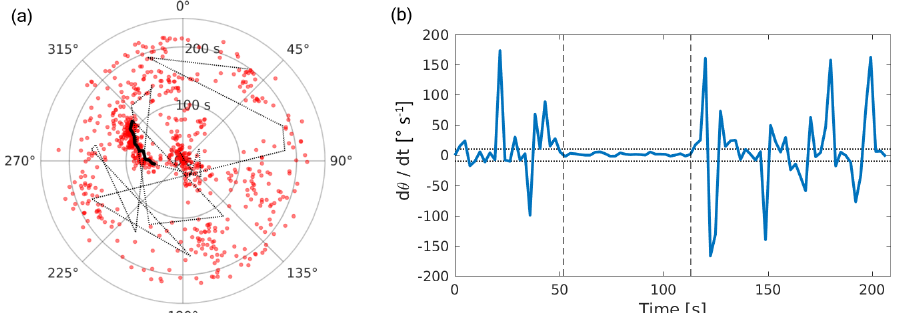
Figure 6. Localization results for an avalanche event recorded on 9 March 2017 at 06:47LT. (a) Polar plot representation of the back-azimuth calculated using the MUSIC method. Red dots are the back-azimuth values for single time windows. The black line represents the median back-azimuth path. The solid part of the line has variations below the threshold value for the derivative, whereas the dotted line refers to strong variations. (b) The derivative of the median back-azimuth path. The dotted lines represents the threshold value of 10 ◦ . The section between 52 and 113s corresponds to the solid line in (a) .